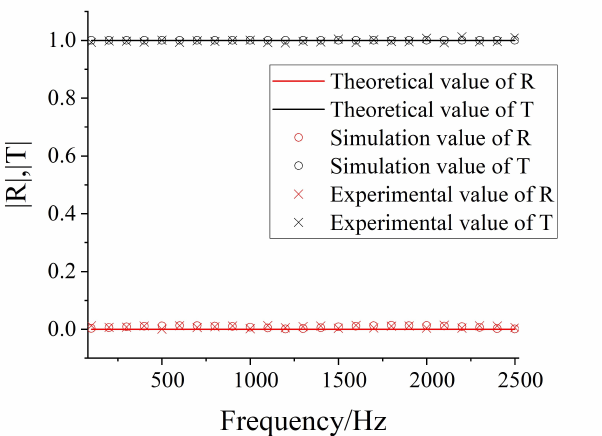
Figure 17. Comparison of the theoretical, the simulation values and experimental values of reflection coefficient (R) and transmission coefficient (T), when there is no sample in the impedance